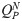
Distribution of modularity in random networks with different number of interactions.Each panel shows the distribution of a modularity score for sparse (20 interactions) and dense (50 interactions) networks with ten nodes. Each sample contains 3,000 random networks. (A) Distribution of the raw modularity score Qopt. Mean ± SD Qopt equals 0.278 ± 0.057 for sparse and 0.135 ± 0.029 for dense networks. Kolmogorov-Smirnov test: D = 0.922; p < 2.2 × 10−16. (B) Distribution of the normalized modularity score QN. Mean ± SD QN equals 0.008 ± 0.981 for sparse and 0.052 ± 0.991 for dense networks. Kolmogorov-Smirnov test: D = 0.064; p = 0.257. (C) Distribution of the raw modularity score QP for a specific partition P. Mean ± SD QP equals −0.002 ± 0.101 for sparse and 3.7 × 10−4 ± 0.05 for dense networks. Kolmogorov-Smirnov test: D = 0.22; p = 6.18 × 10−11. (D) Distribution of the normalized modularity score QPN for a specific partition P. Mean ± SD QPN equals −0.023 ± 1.02 for sparse and 0.007 ± 0.999 for dense networks. Kolmogorov-Smirnov test: D = 0.062; p = 0.29.